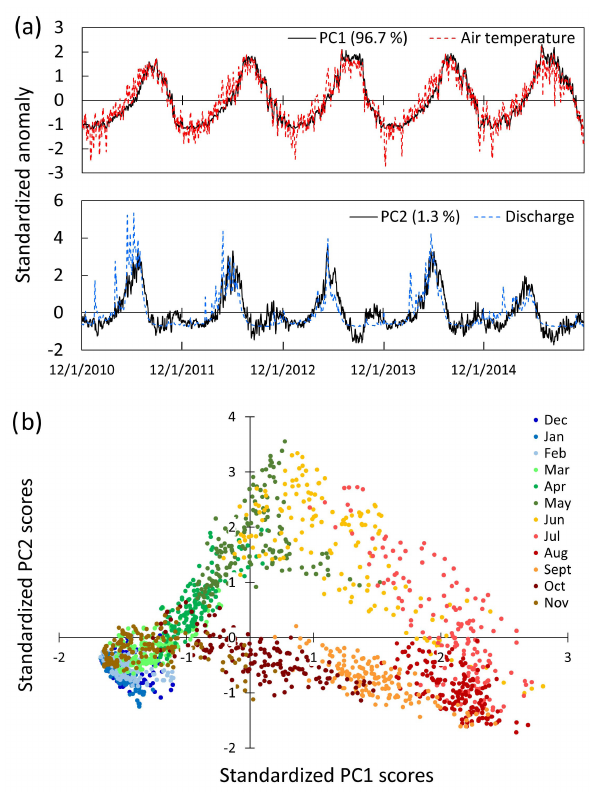
Figure 7. S-mode PCA results showing principal component scores that describe temporal patterns in mean daily water temperatures for 226 stream sites during 5 years (a) . Average daily air temperatures and discharge values from two monitoring stations are aligned with the principal component scores for comparative purposes. A plot of PC1 versus PC2 reveals that variation along the two axes differs by monthly and seasonal periods (b)